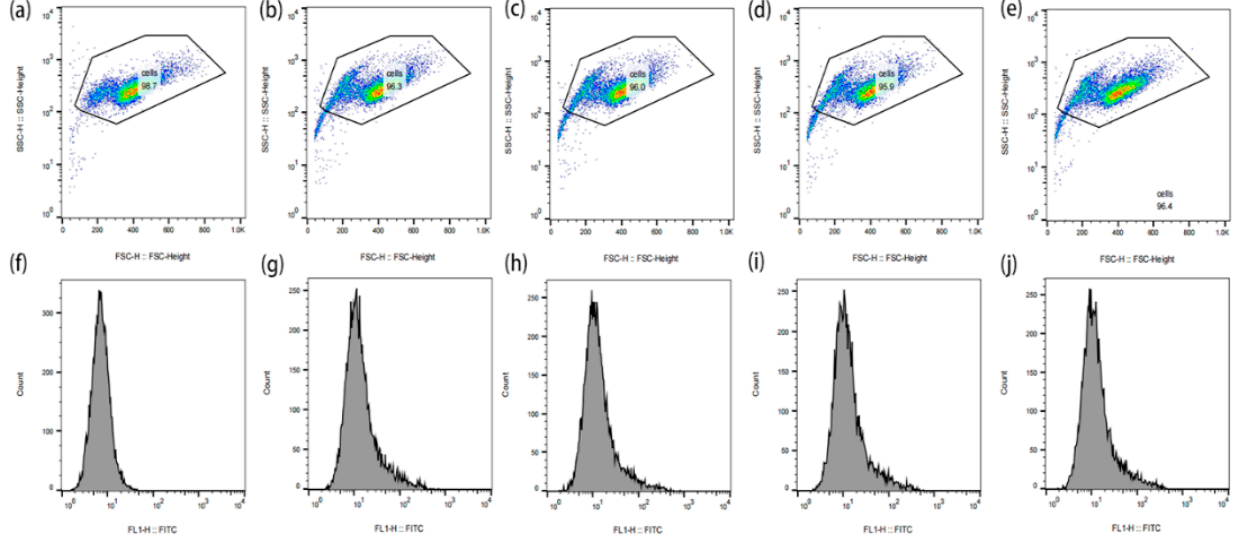
Figure 7. The effect of ROS produced by Au-UCNPs-DSPE-PEG 2K under laser on cells and the change of fluorescence intensity after DCFH-DA staining were measured by flow cytometry ( a ): Blank; ( b – e ): laser for 0 min, 10 min, 20 min, and 30 min, respectively, after adding Au-UCNPs-DSPE-PEG2K; ( f – j ): corresponding to the fluorescence intensity of ( a – e ). The different color in ( a – e ) represents the cell concentration. FITC is that Fluorescein isothiocyanate. FSC is that forward scatter.